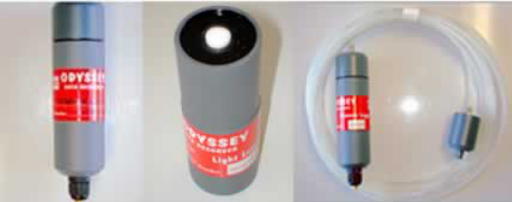
Figure 11. The Odyssey ® data loggers used for the SEMAT Mk2 buoy. From left to right: temperature, photo irradiance (light), and combined